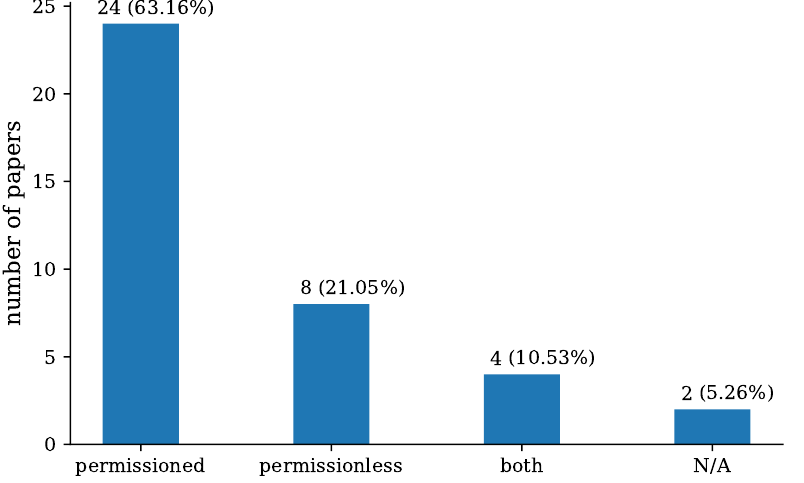
Figure 7. Blockchain types (RQ3) presented in the papers included in our review.